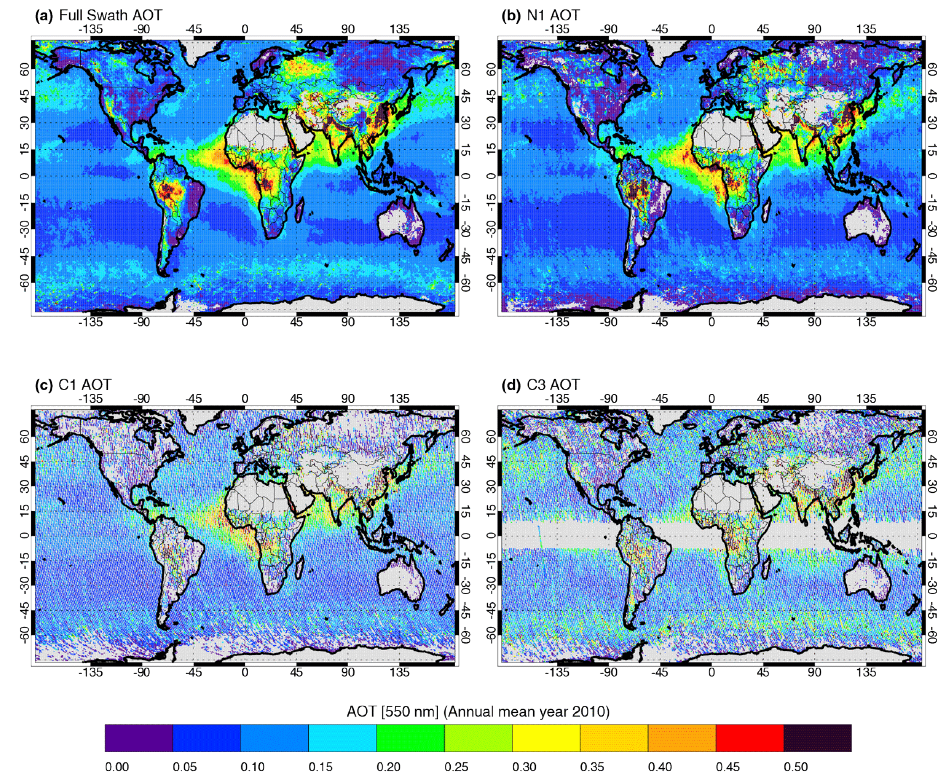
Figure 3. MODIS Aqua year 2010 annual mean AOT using the sampling and aggregation strategy in Eqs. (1) and (2) shown for various along-track spatial samplings: (a) full swath, (b) N1, (c) C1, and (d) C3. The grey shading indicates locations where no MODIS AOT retrievals were made during the